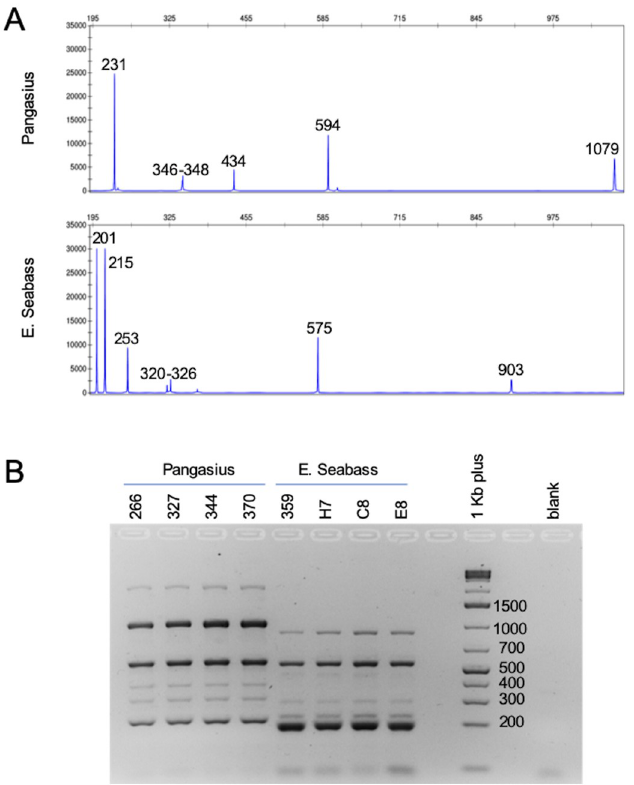
Fig 2. Comparison between seabass and pangasius aTBP. A) electropherograms obtained from pangasius (top panel) and European seabass (bottom panel) respectively. Reported numbers on top of the peaks refer to the sizes of the amplified fragments. A typical example is shown. Complete data are reported in S1 Table. B) Separation in agarose gel of the aTBP fragments amplified from pangasius or seabass samples. The numbers and letters above the agarose gel indicate the samples analyzed. The numbers next to the “1kb plus” marker indicate the molecular weights of each fragment.